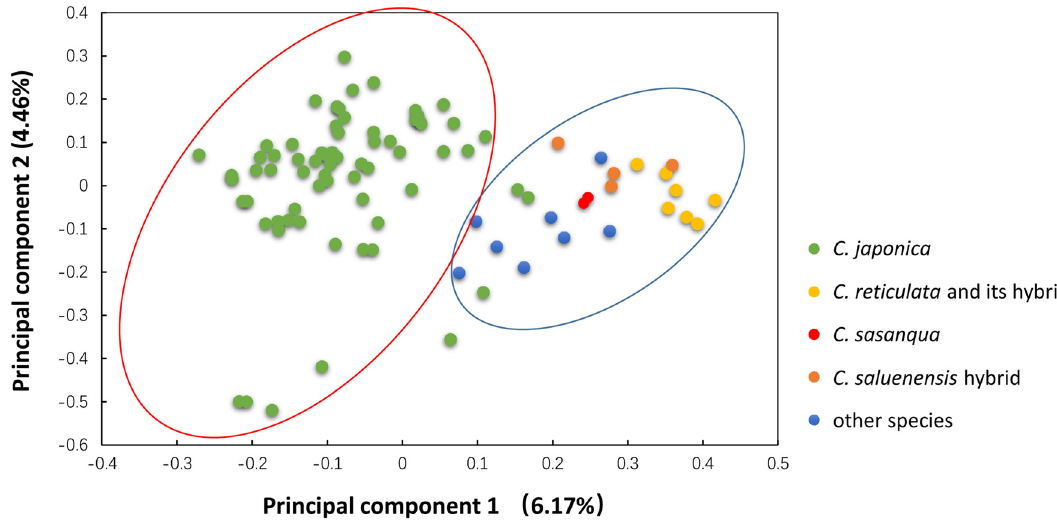
Figure 5. PCA using the first and second eigenvectors identified 89 camellia accessions.